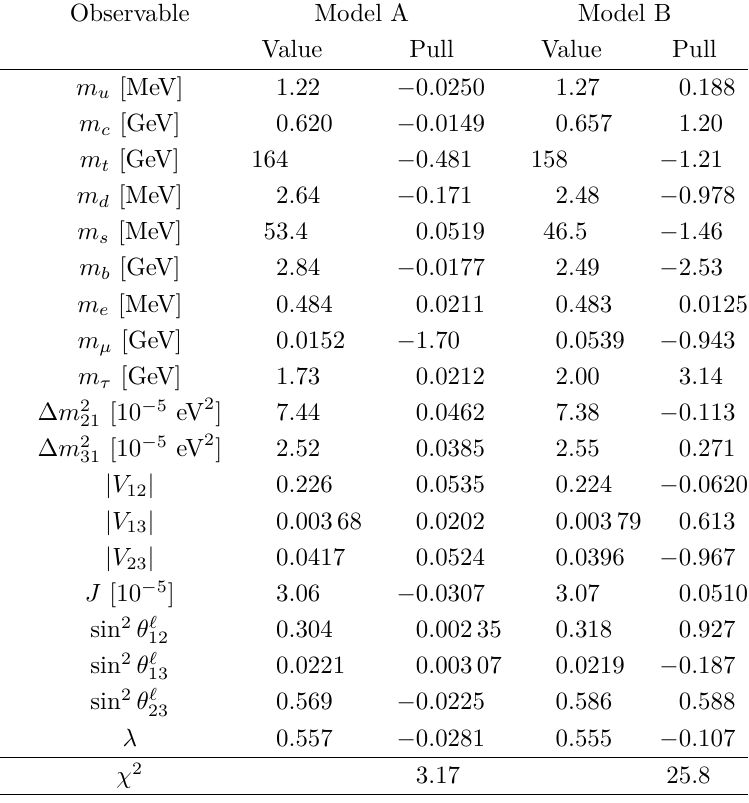
Table 4 . Pulls of each observable included in the fit, for models A and B with top-down RG running. Defined such that a positive pull implies that the predicted value is larger than the corresponding true